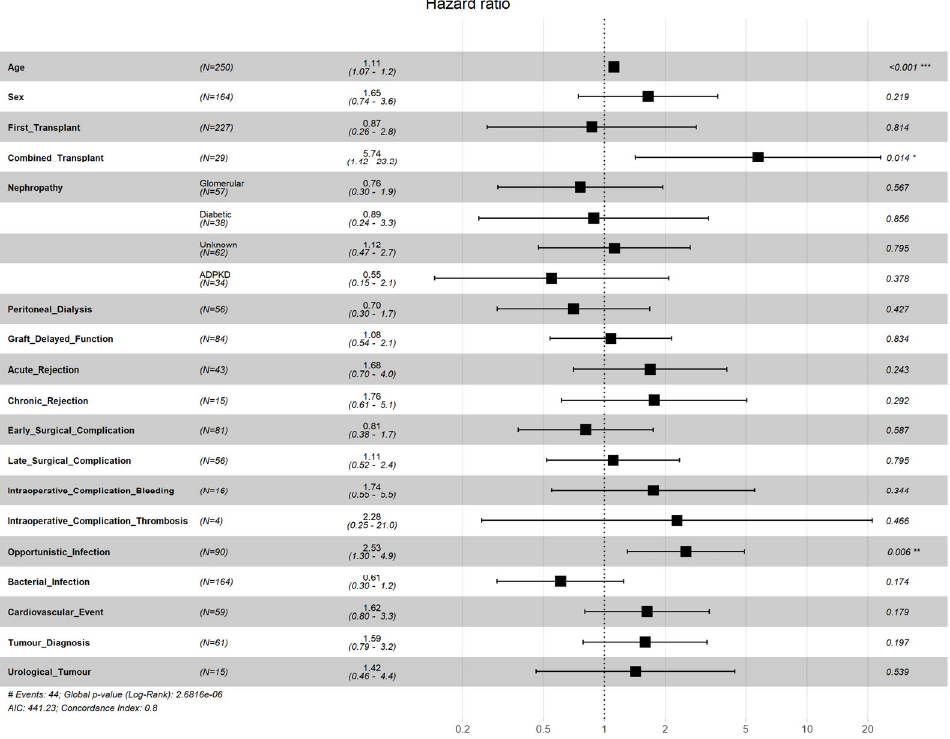
Figure 3. Results of the Cox proportional hazards model for overall survival, including the clinical selection of the studied variables. * p ‐ value < 0.05, ** p ‐ value < 0.01, *** p ‐ value < 0.001.